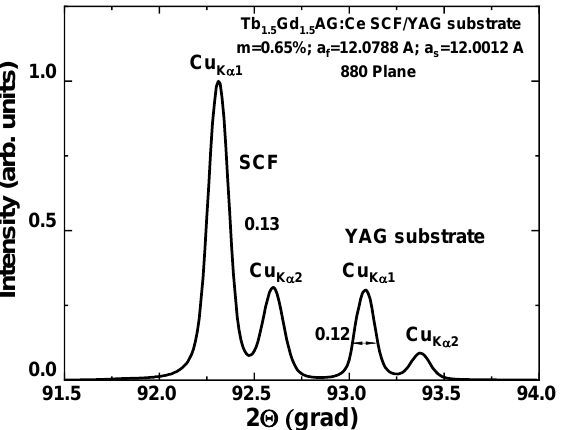
Figure 2. XRD pattern of 880 plane of 6 μm -thick TbGdAG:Ce SCF grown on (110) oriented YAG substrate.